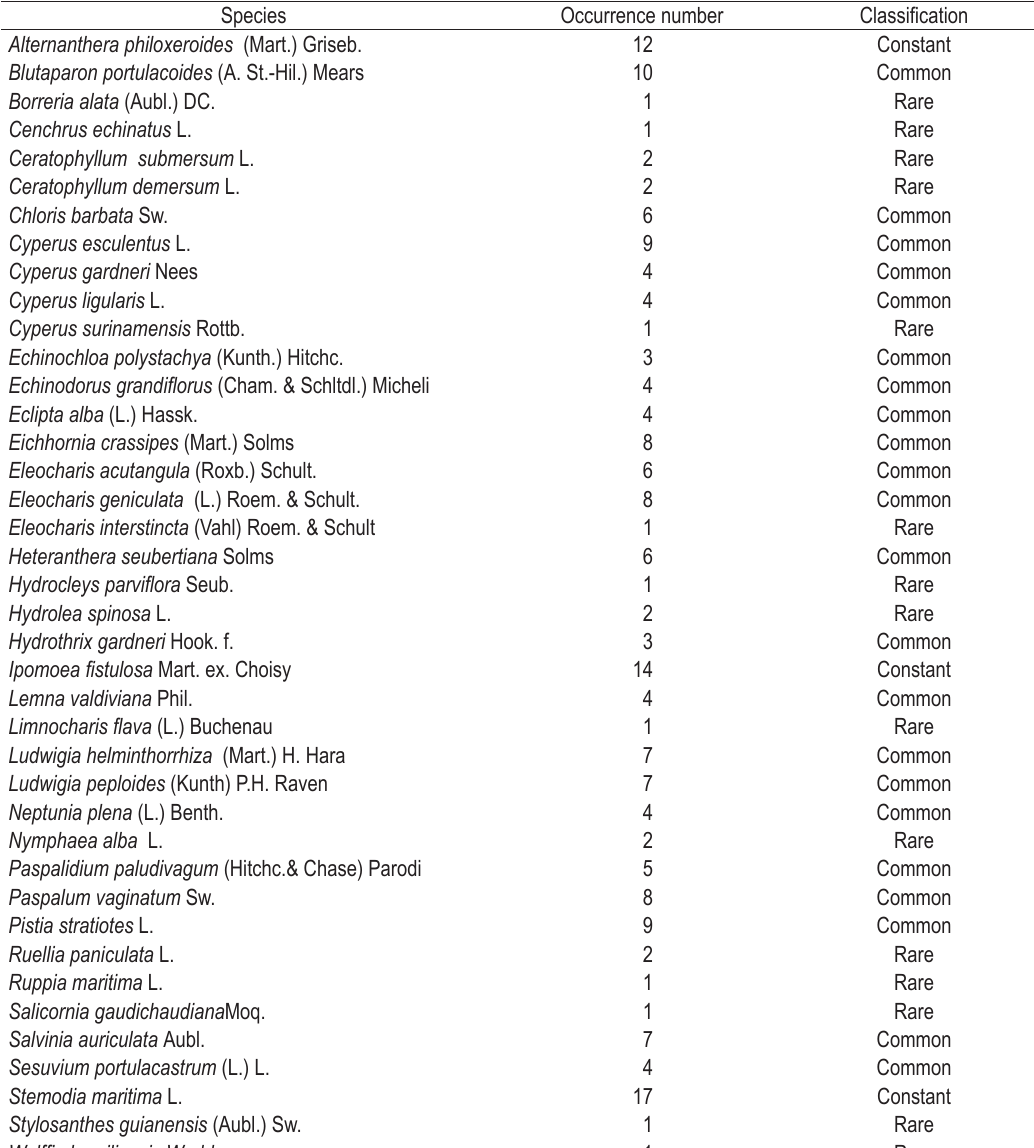
Figure 3. Number of occurrence of species, per principal genera, in 20 sampling stations of the basin of the Apodi/ Mossoró River, RN, Northeast Brazil. Table 2. Classification according to frequency of occurrence of aquatic macrophytes from hydrographic basin of the Apodi/Mossoró River, RN, Northeast Brazil.